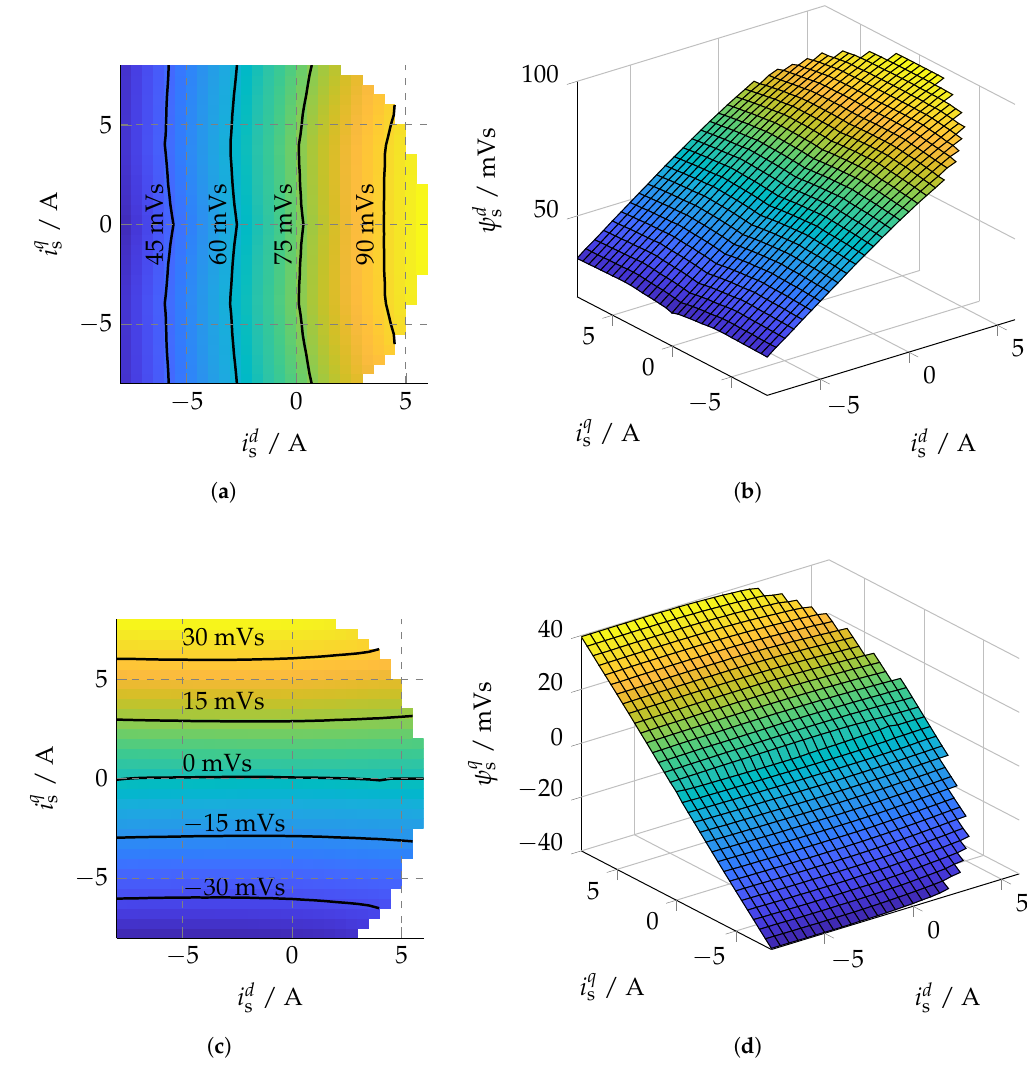
Figure 5. Measured flux linkage maps. ( a ) Flux linkage ψ d s with black contour lines of constant flux linkage; ( b ) Flux linkage ψ d s in a 3D plot; ( c ) Flux linkage ψ q s with black contour lines of constant flux linkage; and ( d ) Flux linkage ψ q s in a 3D